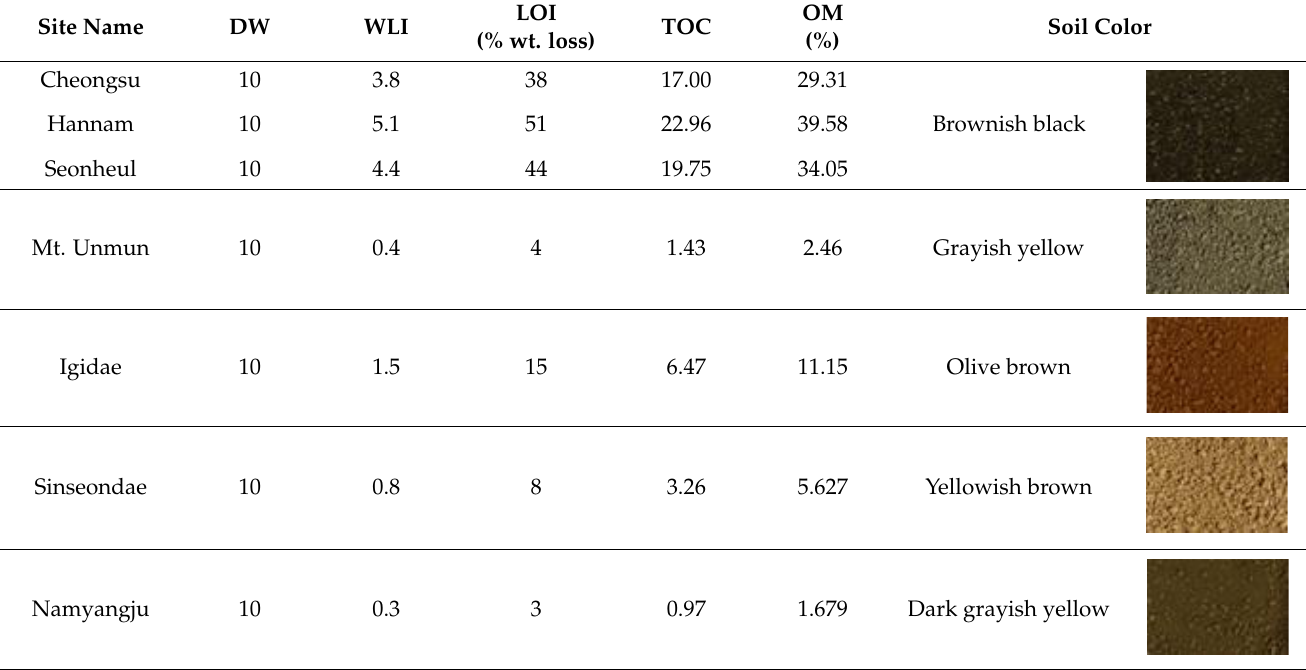
DW: dry weight; WLI: Wt. loss on ignition; LOI (%): loss on ignition; TOC: total organic carbon; OM: organic matter. The field survey also revealed that preferred habitats of L. unmunsana included forest edges with abundant water resources such as a lake or continuously wet valley (Figure 4). This suggests that humidity, as well as soil organic matter, may be a key factor in habitat preference. However, survival of L. unmunsana populations in regions with steep and/or rough topography (e.g., Mt. Unmun, three regions in Busan, Gyeongsan, etc.) suggests that L. unmunsana can survive regardless of topsoil and humidity conditions. The popu- lation occurrence of L. unmunsana is along the Mt. Unmun’ s biggest watershed where there is a continuously wet valley that contributes humidity for its habitat, even without significant soil organic matter (Figure 4h). Three regions in Busan (Igidae, Sinseondae and Taejongdae) also supported small populations of L. unmunsana despite having less than ideal soil and topographic conditions. These regions receive moist air carried by sea winds from the East Sea (Figure 4c).